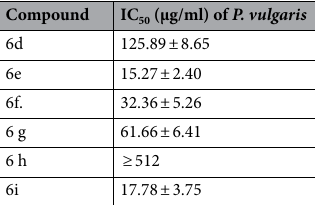
Table 2. Urease inhibitory activity of selected compounds against P. vulgaris.